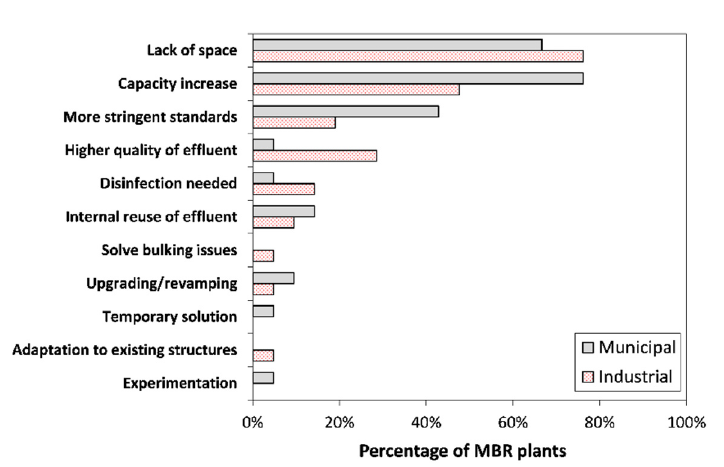
Figure 5. Driving forces for installing MBR systems.